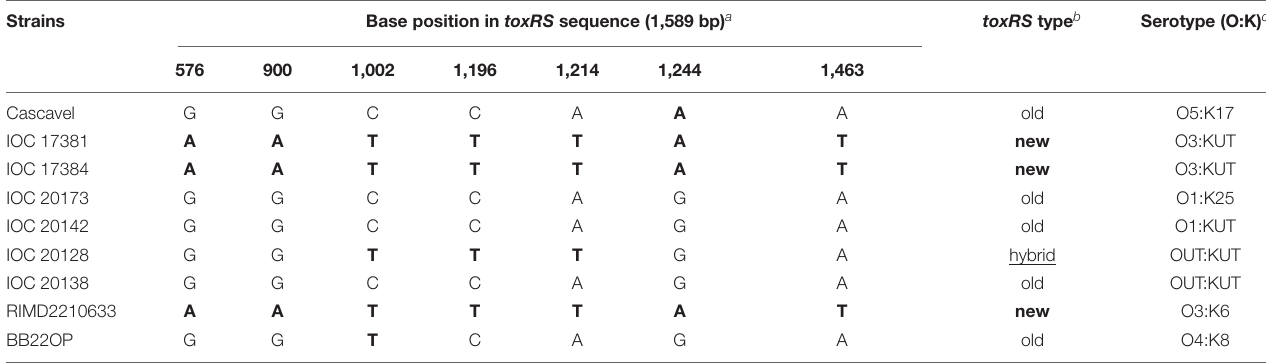
TABLE 3 | Bases in seven positions within the 1,589-bp toxRS sequence of Vibrio parahaemolyticus strains. Strains Base position in toxRS sequence (1,589 bp) a